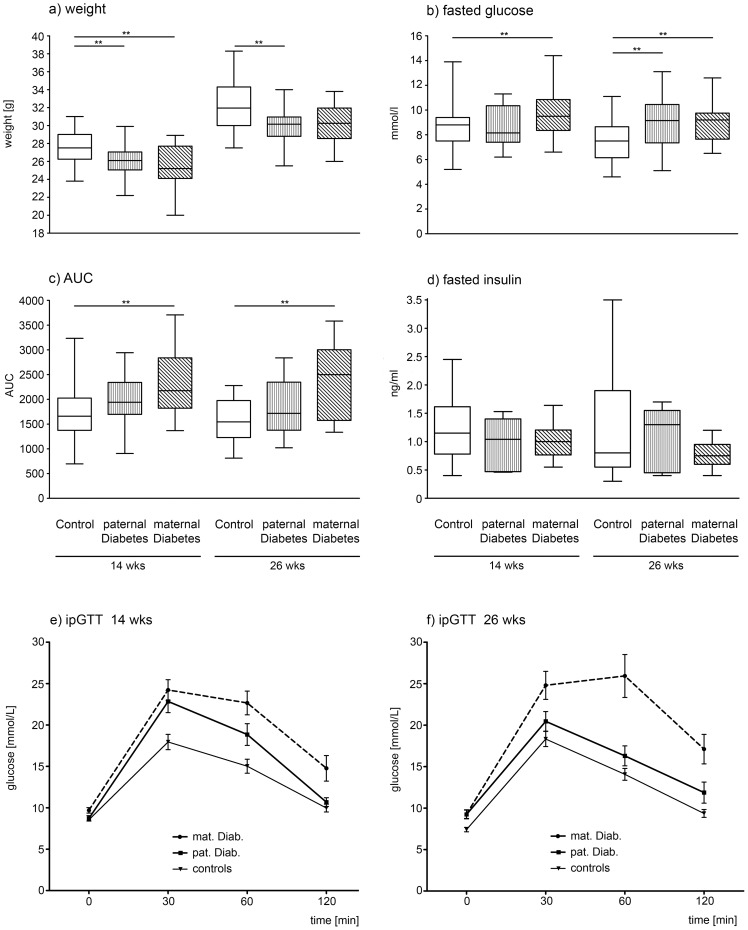
Metabolic Outcomes in Wildtype Male Offspring.Boxplots showing the smallest observation (lower bar), lower and upper quartile (box), median (line in the box) and largest observation (upper bar) of selected phenotypic markers: a) weight in g, b) fasted, glucose in mmol/L, c) AUC and d) fasted insulin (ng/ml) are given for male offspring of control breedings (open bars), paternal diabetes (longitudinal shading) and maternal diabetes (diagonal shading), at 14 and 26 weeks of age. Mean glucose ± STD during ipGTTs for offspring of maternal diabetes, paternal diabetes and controls are shown for 14 (panel e) and 26 week (panel f) old males. Glucose clearance after ip bolus of glucose (ipGTT) was significantly impaired at all time points for offspring of maternal diabetes, and at 30 and 60 minutes in 14 week old mice, and at 60 minutes after injection in 26 week old offspring of paternal diabetes. * Denotes statistically significant difference vs. control (*p<0.05, ** p<0.01, *** p<0.001).